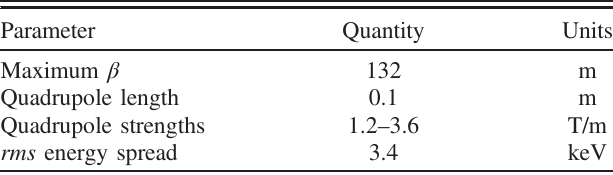
TABLE XI. Select magnet properties of the final focusing section.